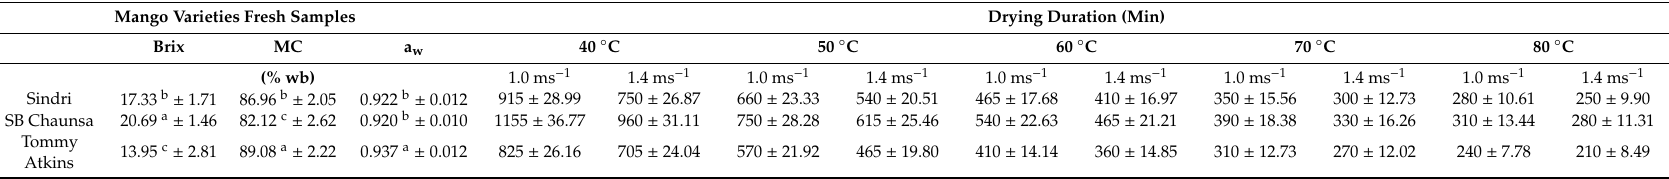
Table 1. Brix, moisture content (MC) percentage wet basis, water activity (a w ), and drying duration of mango varieties Sindri, SB Chaunsa, and Tommy Atkins at temperatures of 40 ◦ C to 80 ◦ C; air velocities 1.0 ms − 1 and 1.4 ms − 1